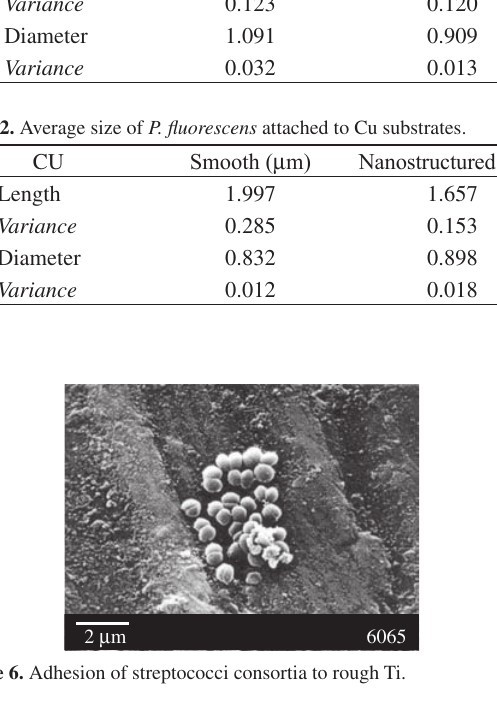
Figure 7. Epifluorescence microscopy corresponding to a rough titanium surface where rows of streptococci with preferential direction can be seen within the valleys.